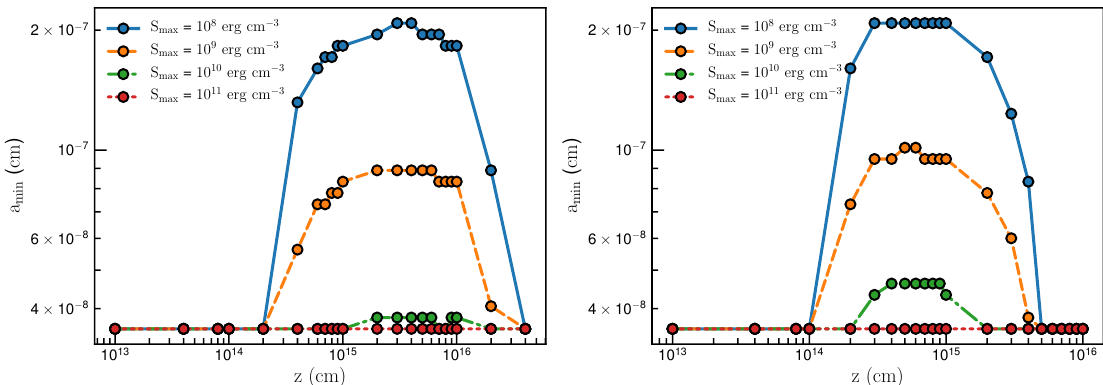
Figure 31. Minimum size below which polycyclic aromatic hydrocarbons (PAHs) are destroyed by rotational disruption vs. distance in the shock, assuming the different material tensile strengths for v s = 30kms − 1 . Two shock models with gas density n H = 10 4 cm − 3 (left panel) and n H = 10 5 cm − 3 (right panel). From Hoang and Tram